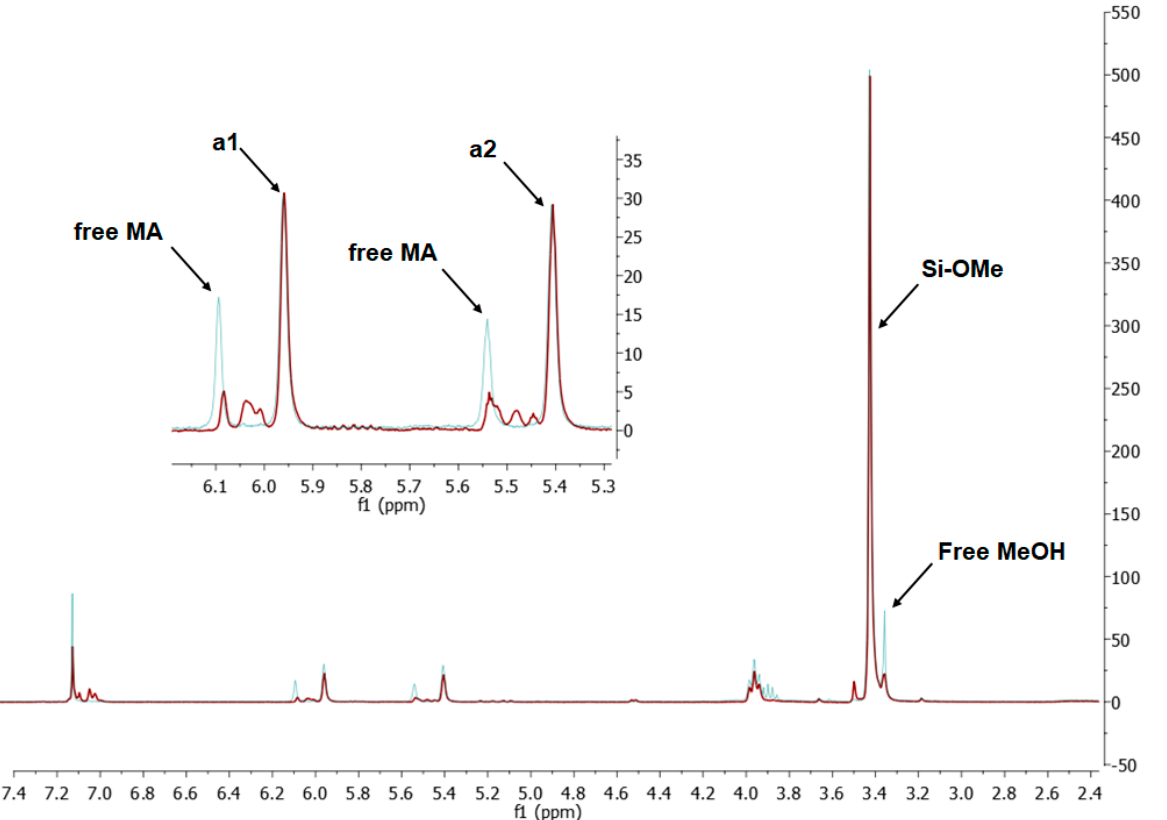
Figure 5. 1 H NMR spectrum of hydrolysis product of SS-4MA-4TMOS in iPrOH-H 2 O solution (blue) and neat SS-4MA-4TMOS (red). The spectra are superimposed for the comparison purpose.